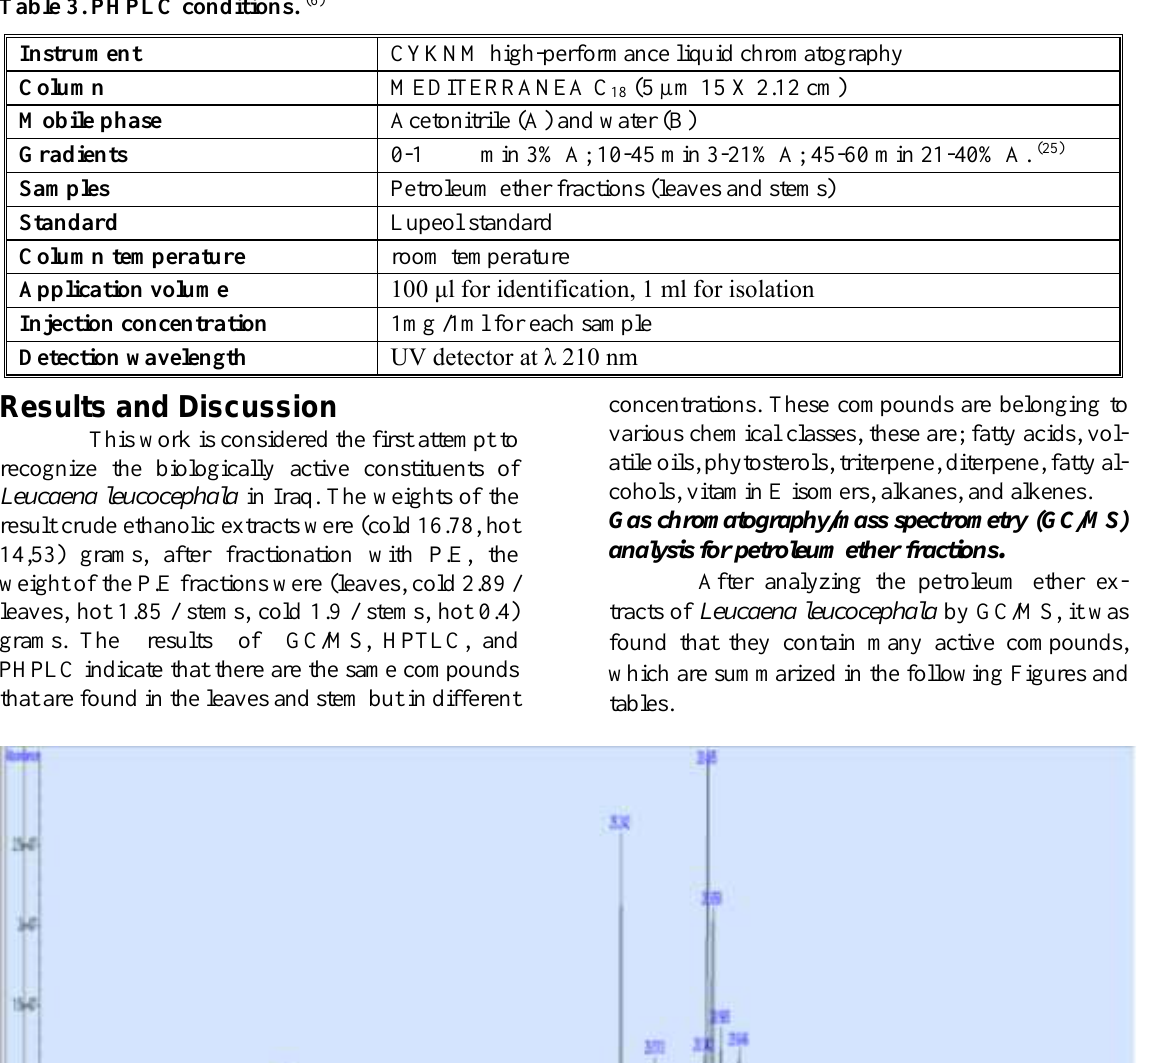
Table 3. PHPLC conditions. (6)